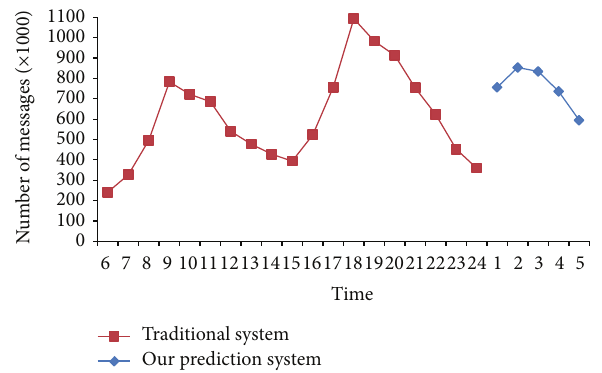
Figure 4: Number of messages transmitted to the centralized